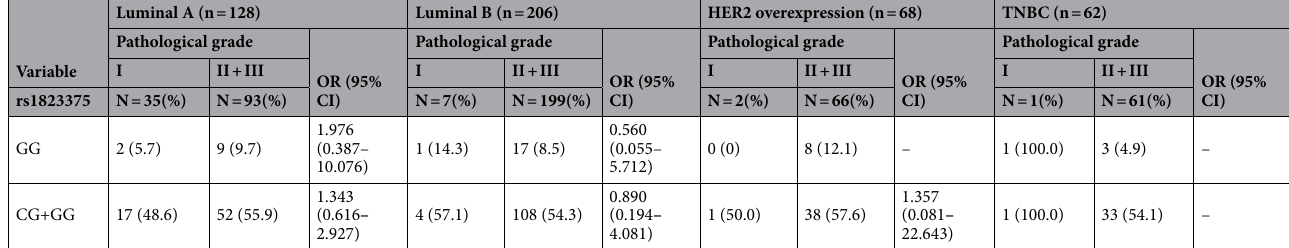
Table 4. Odds ratios (ORs) and 95% confidence interval (CIs) of Ang2 genotypic frequencies and clinical subtypes in patients with malignant breast neoplasms. The ORs and their associated 95% CIs were estimated by logistic regression models. * p < 0.05 was considered to be statistically significant. HER2, human epidermal growth factor receptor 2; TNBC, triple-negative breast cancer. Pathological grade: I, well differentiated; II, moderately differentiated; III, poorly differentiated. Significant values are in bold.